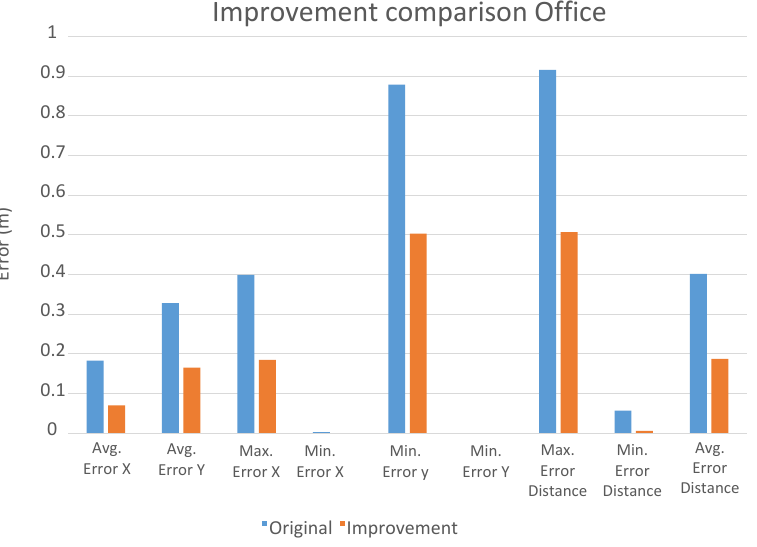
Figure 6. Results for the office pose estimation reached by applying the proposed method to improve the accuracy of the regression